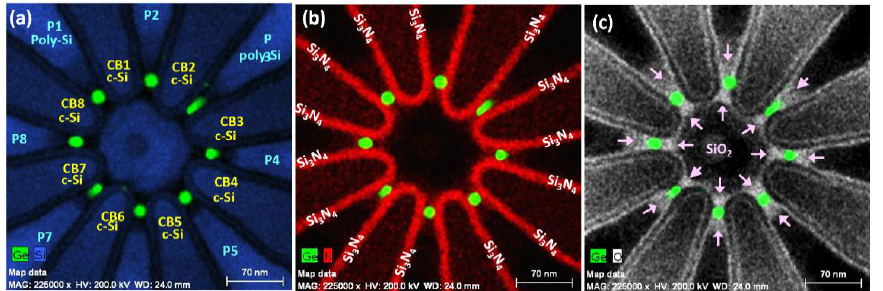
Figure 5. Plan-view EDS maps of elemental ( a ) silicon (Si — blue), germanium (Ge — green); ( b ) ni- trogen (N — red), Ge; and ( c ) oxygen (O — white), Ge of octuple Ge QDs fabricated at each included- angle location of asterisk-shaped Si ridges with Si 3 N 4 overlayers. gen (N—red), Ge; and ( c ) oxygen (O—white), Ge of octuple Ge QDs fabricated at each included-angle location of asterisk-shaped Si ridges with Si 3 N 4